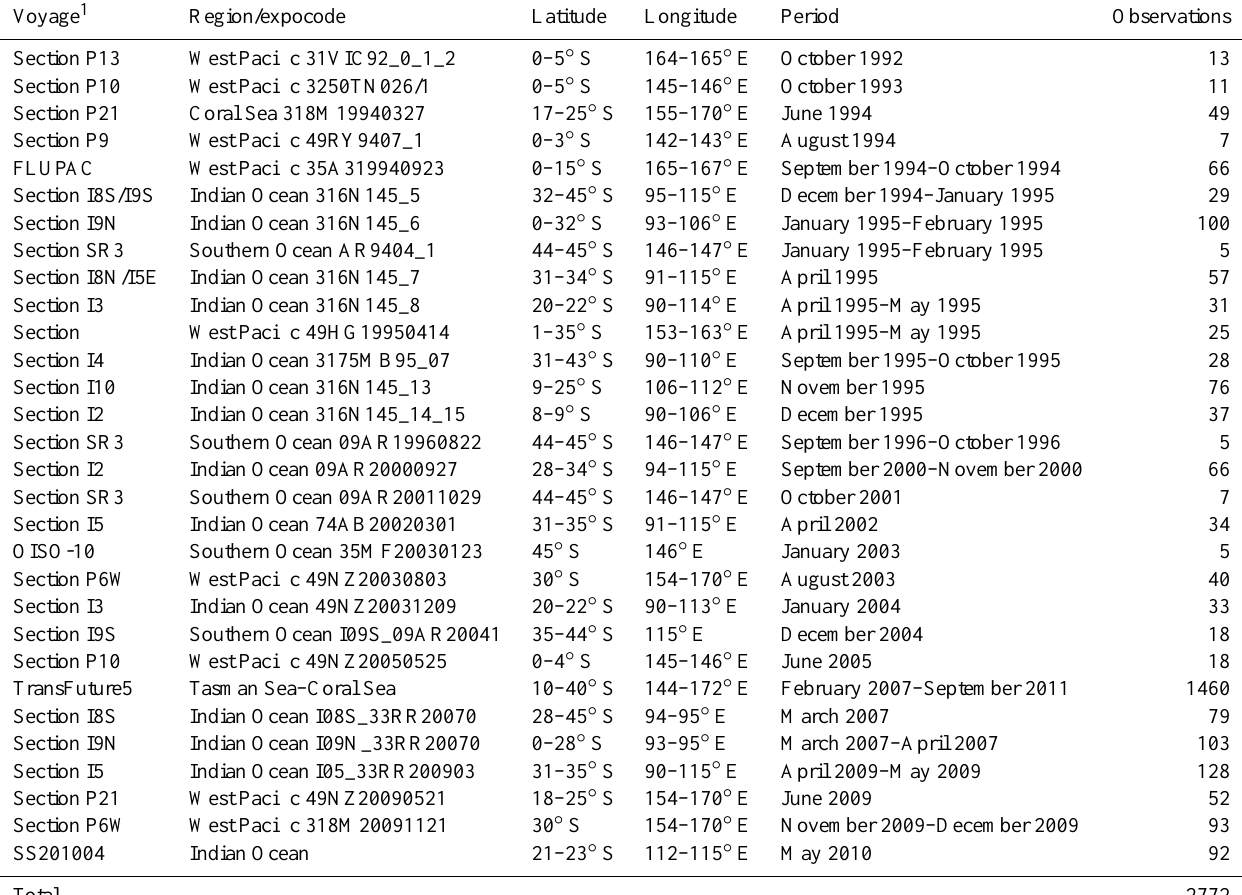
Table 1. Cruise data used to derive the salinity versus total alkalinity relationship for surface waters in Australian regional seas. FLUPAC: Flux dans l’ouest du Pacifique équatorial; OISO: Océan Indien Service d’Observation; SS: Southern